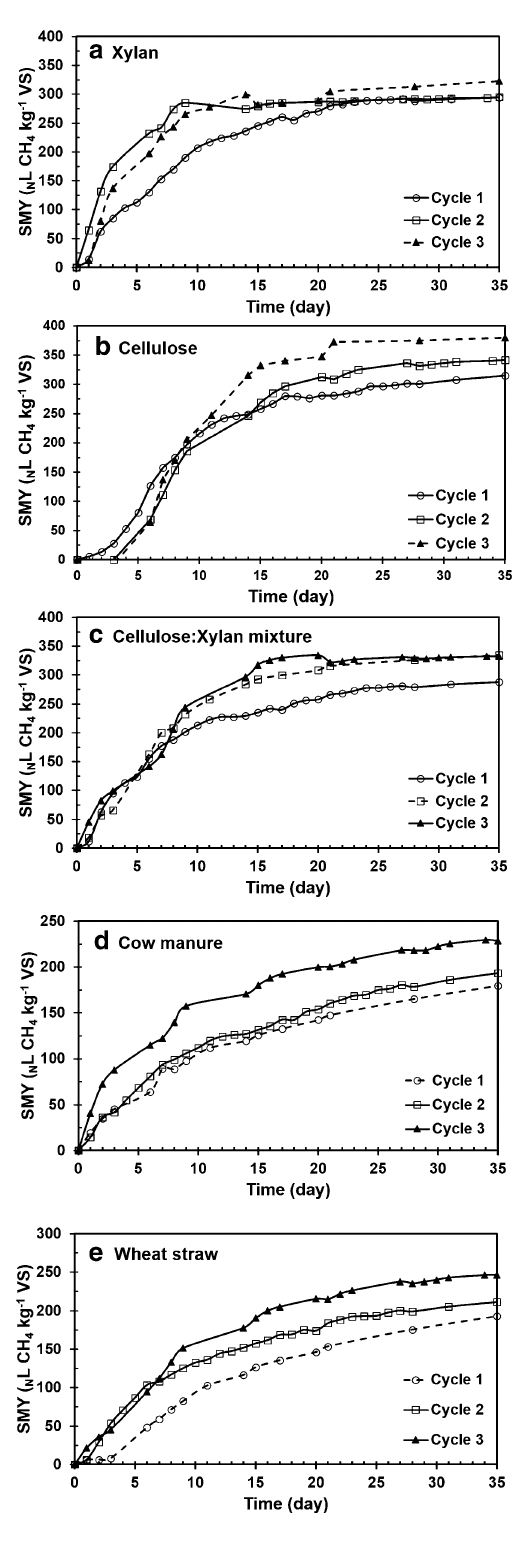
Fig. 1 Profile of specific methane yield (SMY) during the first 35 days of the anaerobic digestion at 20 °C in successive cycles (val- ues shown are average of duplicate bioreactors)